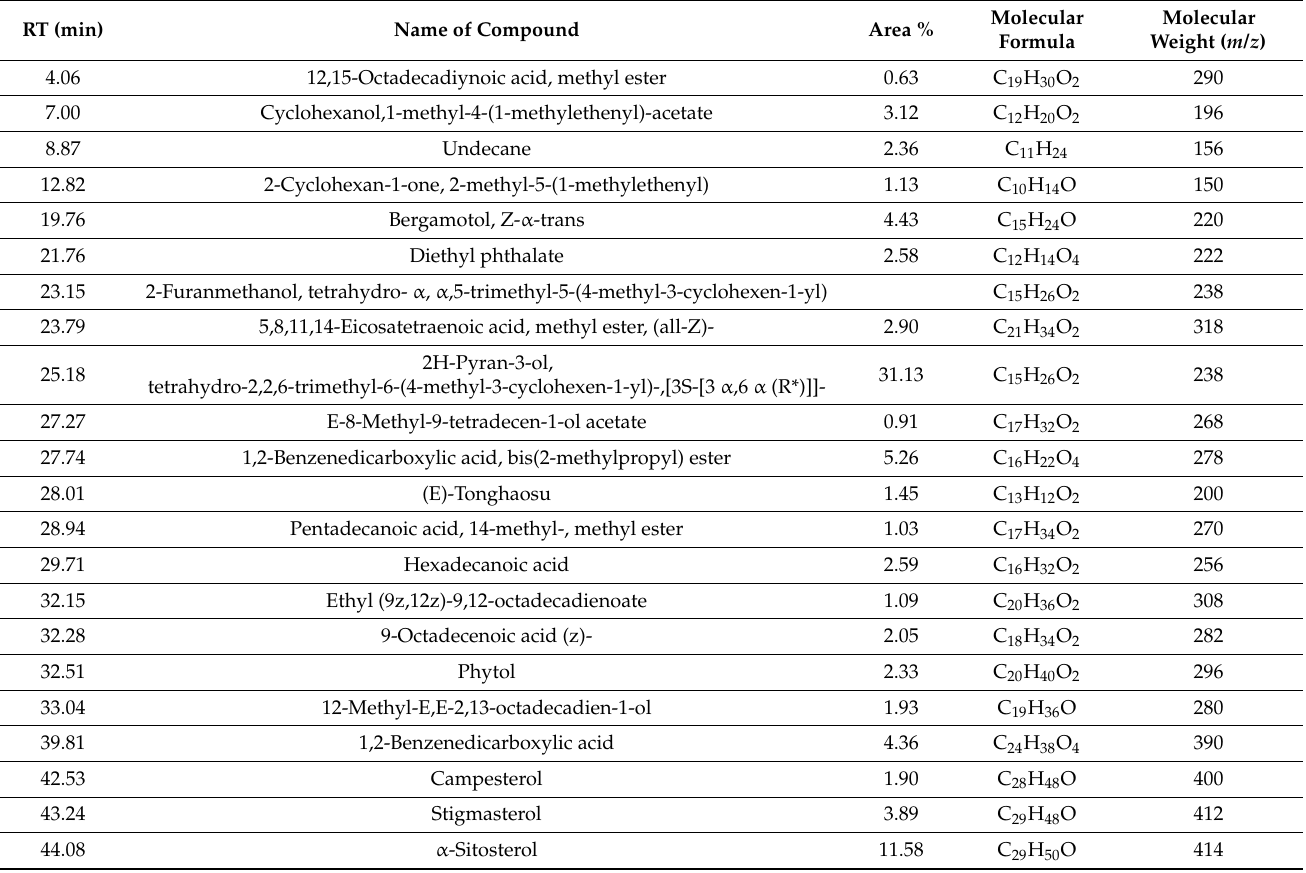
Table 1. GC–MS chromatography identified major chemical components of bioactive compounds in the ethyl acetate crude extract of Avicennia marina leaves. Adapted from [14].